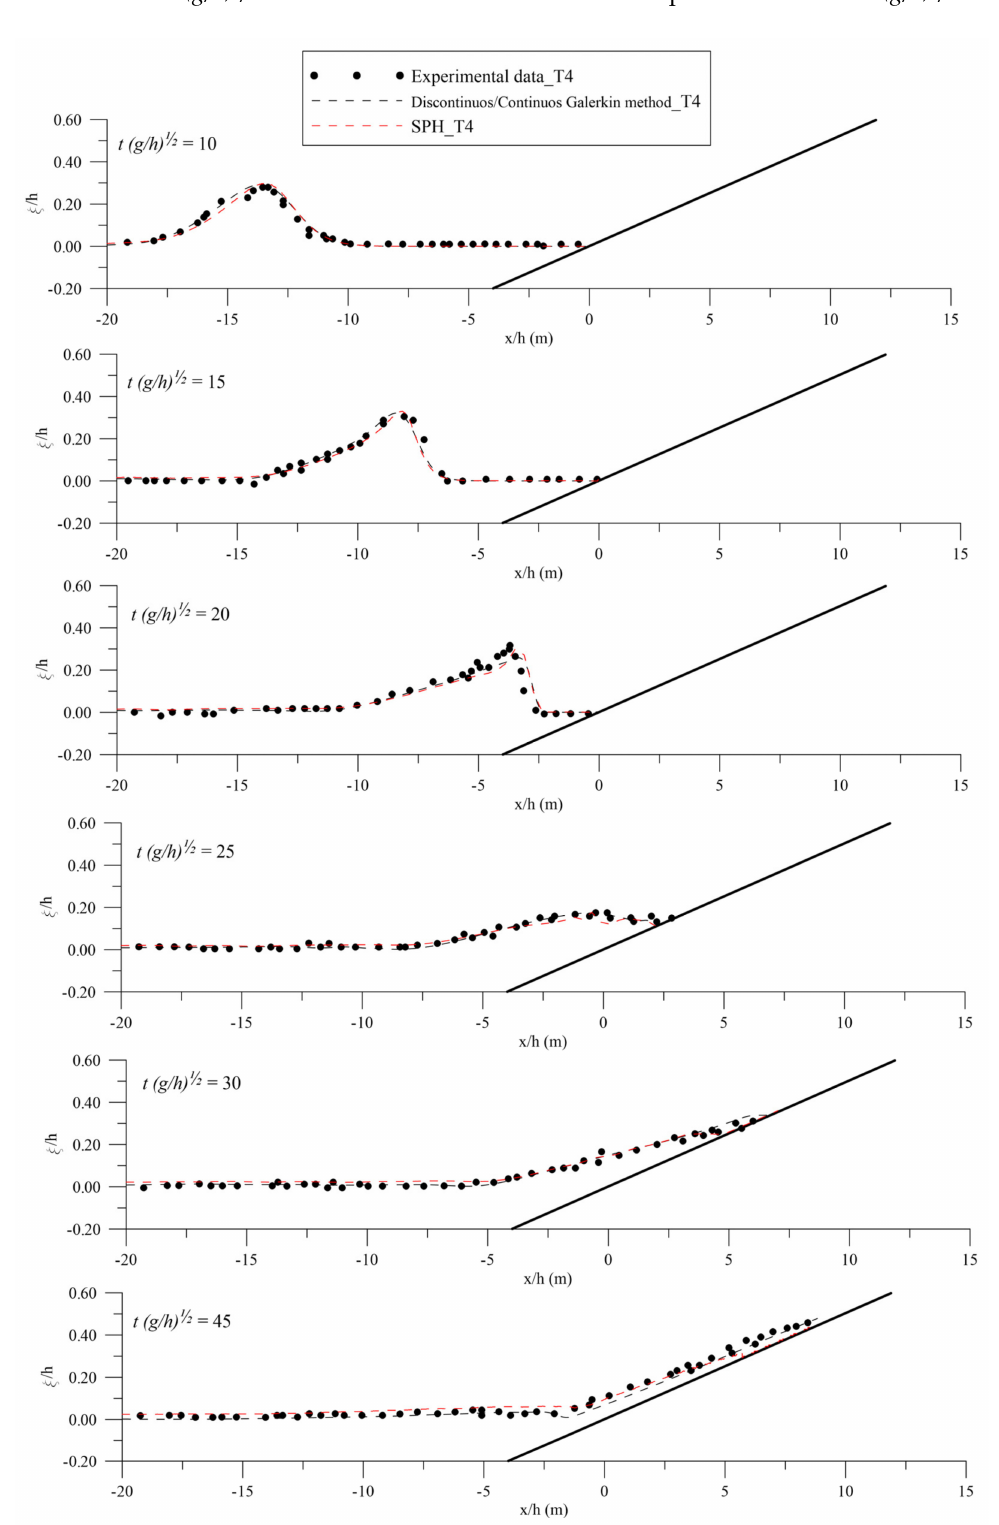
Figure 8. Comparison of experimental and numerical surface profiles of a solitary wave run-up on a plane beach